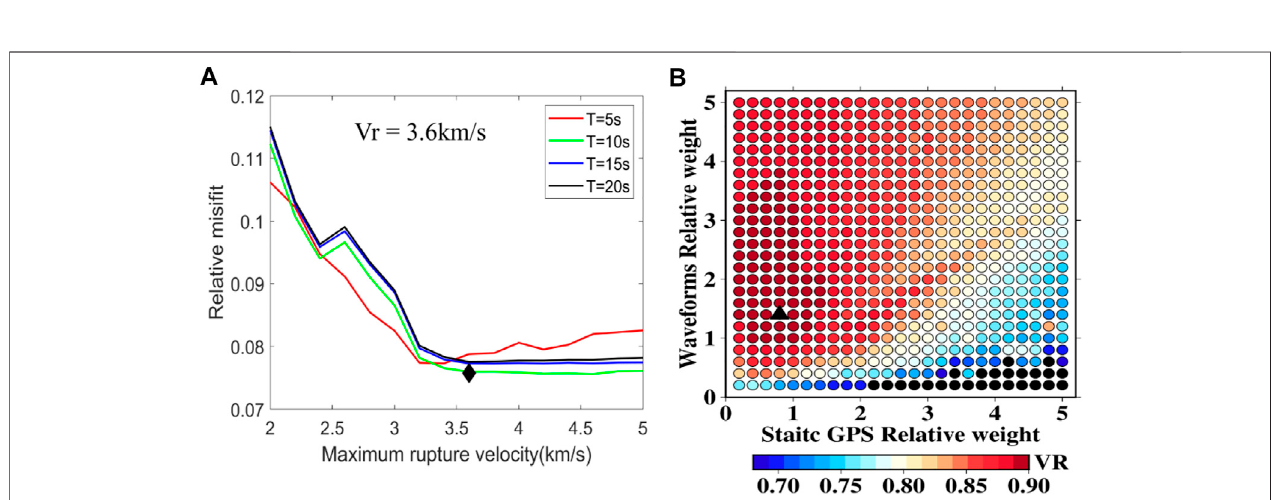
FIGURE4|(A) Normalizedmis fi tplottedagainstdifferentmaximumrupturevelocitiesformaximumrupturedurationsof5 s(red),10 s(green),15 s(blue),and20 s (black). The black diamond marks the maximum rupture velocity of 3.6 km/s and a maximum rupture duration of 10 s for each subfault used in this study. (B) Total VR distribution with different relative weights of static GPS and waveform data. The black triangle marks the relative weight. The static GPS and waveform are 0.8 and 1.4, respectively, used in this study.